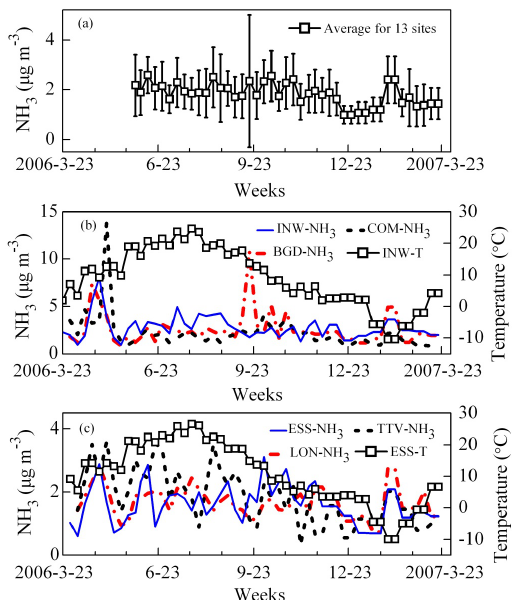
Fig. 4. Temporal variations of NH 3 in 2006–2007at sites located in the medium concentration zones sites but with spikes during the coldest temperature periods: (a) the spatially averaged value over 13 sites, (b) three sites having spikes before the early of June, and (c) three sites having no spikes before the early of June.